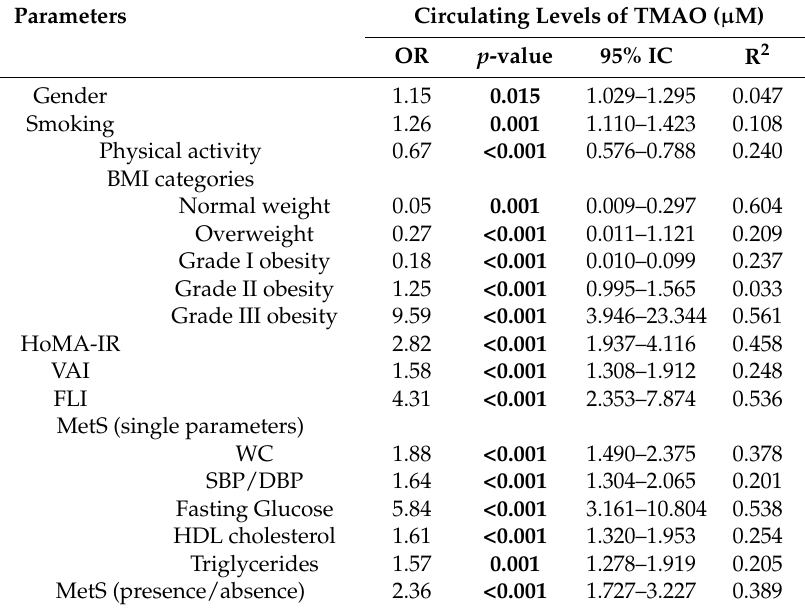
Table 4. Bivariate proportional odds ratio model to assess the association between circulating levels of TMAO and gender, lifestyle habits, cardio-metabolic indices, and MetS.